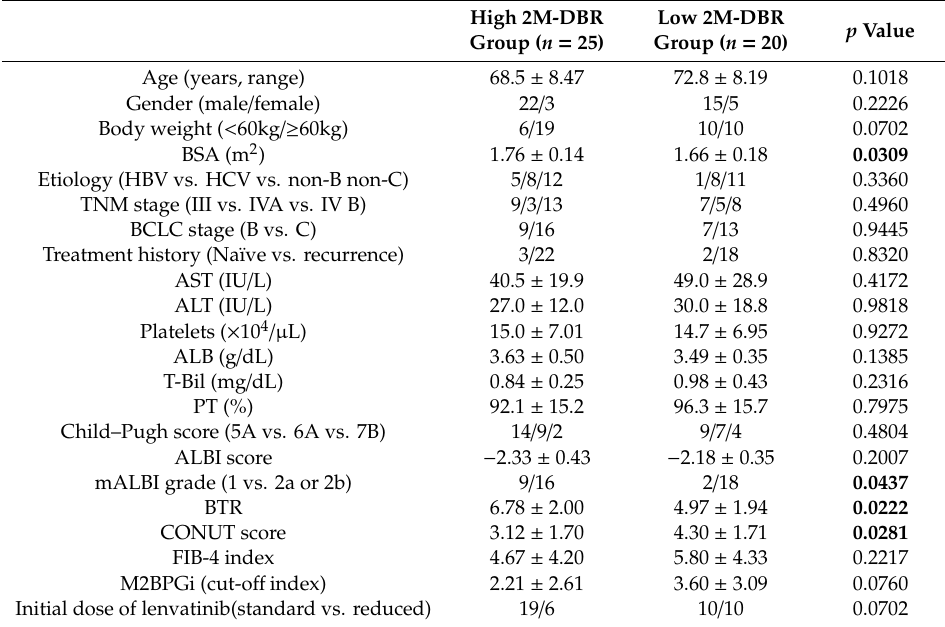
Table 5. Comparison between patients with high 2M-DBR and low 2M-DBR.